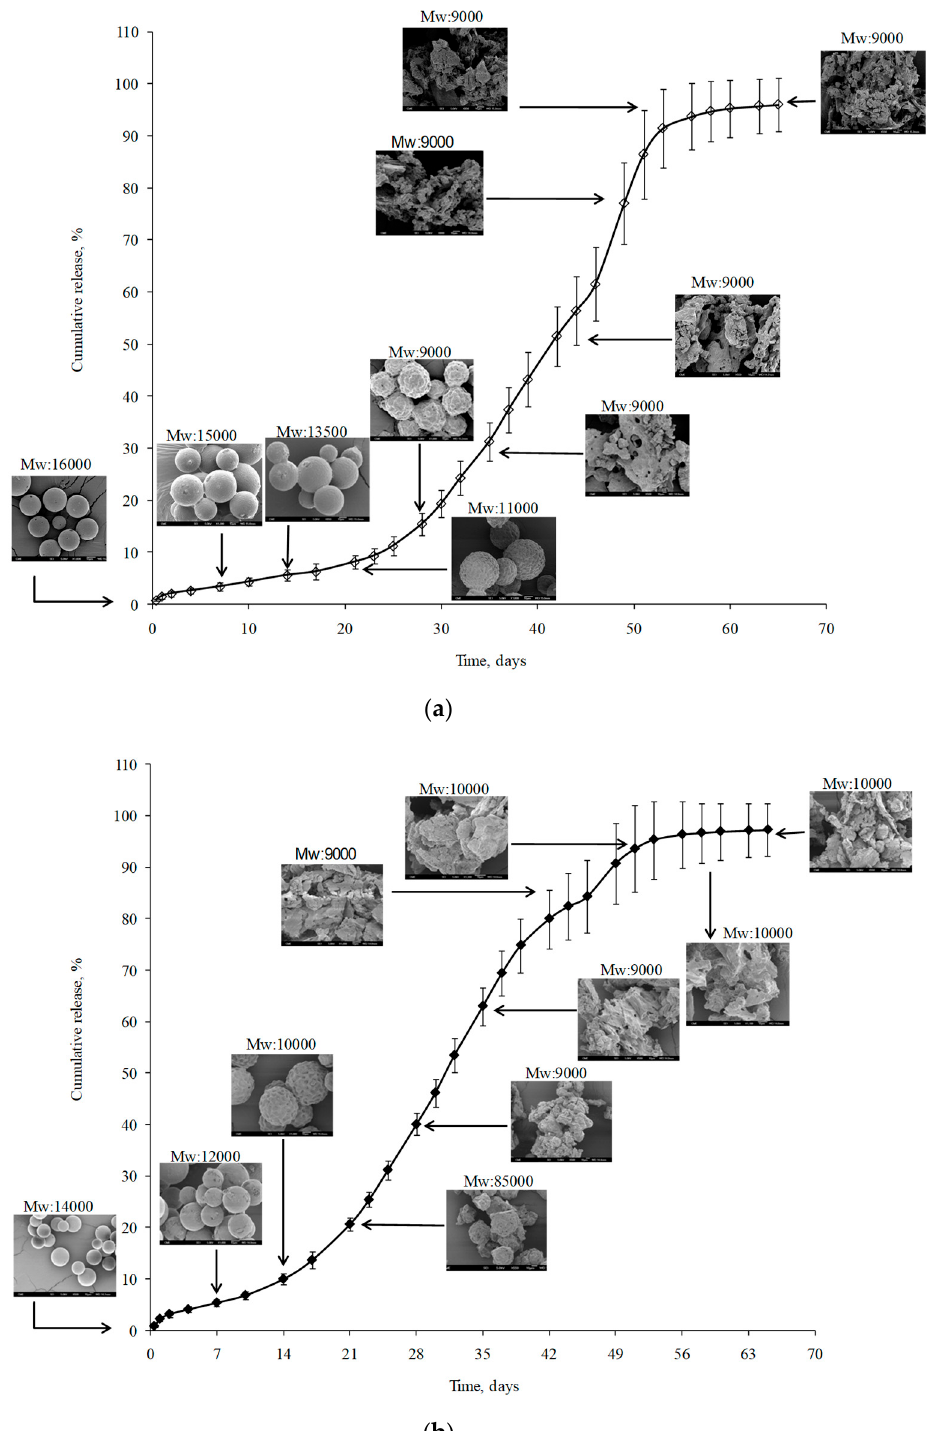
Figure 7. PLGA molecular weight (gel permeation chromatography (GPC) data) and microsphere morphology (SEM pictures) during the in vitro release assay of non-sterilized ( a ) and sterilized ( b ) microspheres.